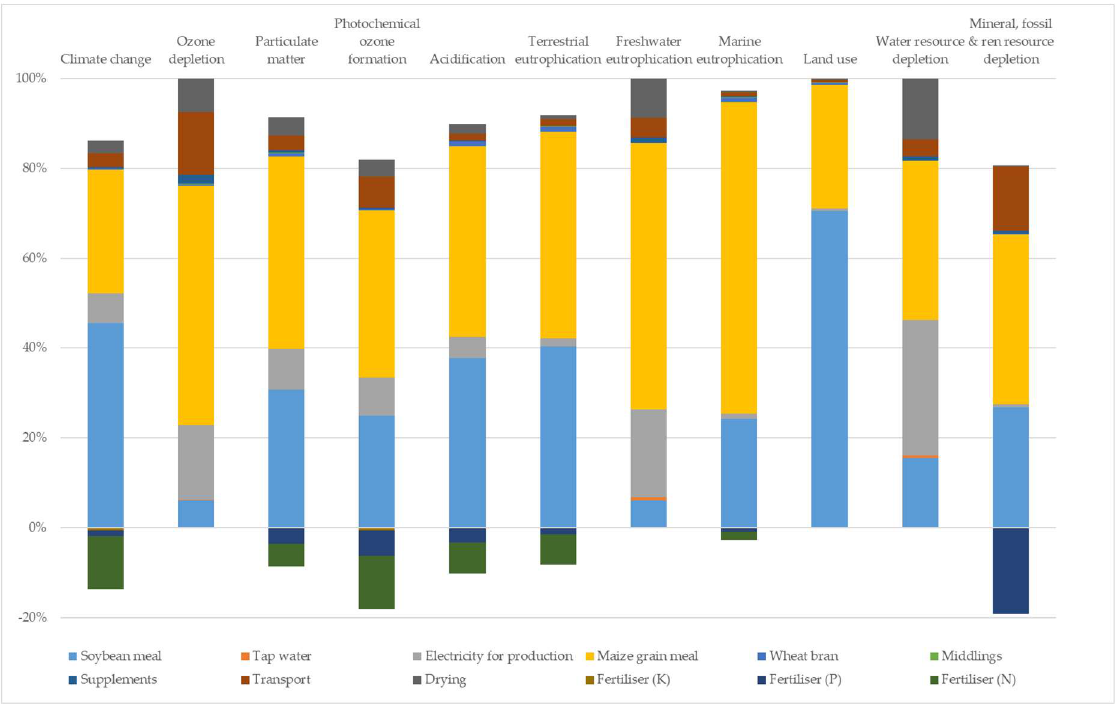
Figure 2. Relative weight of different processes of larvae grown on a hen diet.